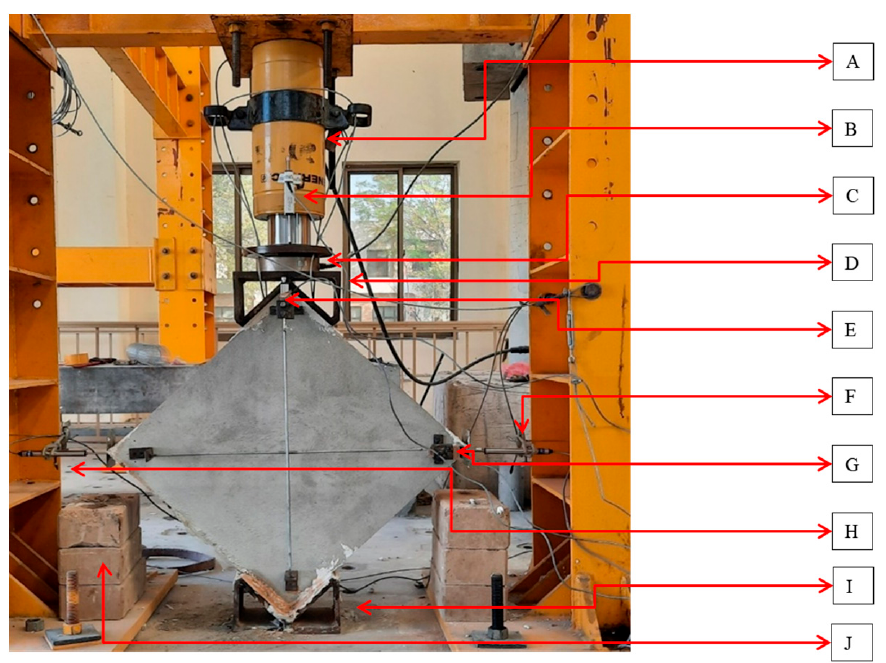
Figure 5. Diagonal tension testing instrumentation: (A) hydraulic jack; (B) top vertical LVDT; (C) 50-ton load cell; (D) top loading shoe; (E) internal vertical LVDT; (F) external horizontal right LVDT; (G) internal horizontal LVDT; (H) external horizontal left LVDT; (I) bottom loading shoe; (J) supports in case of sample collapse.